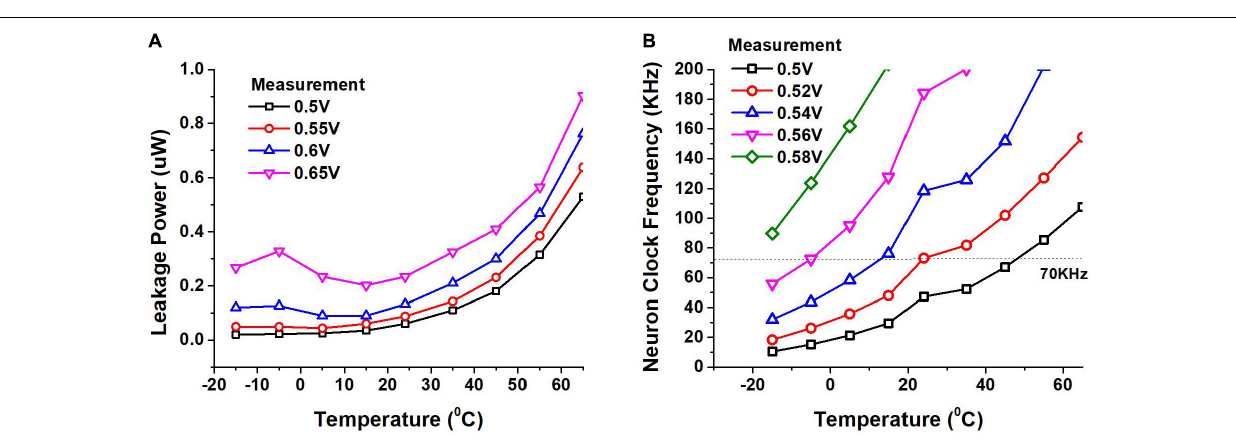
FIGURE 12 | (A) Leakage power of the chip measured as a function of temperature at different supply voltages. (B) Variation of neuron clock frequency measured as temperature and supply voltage